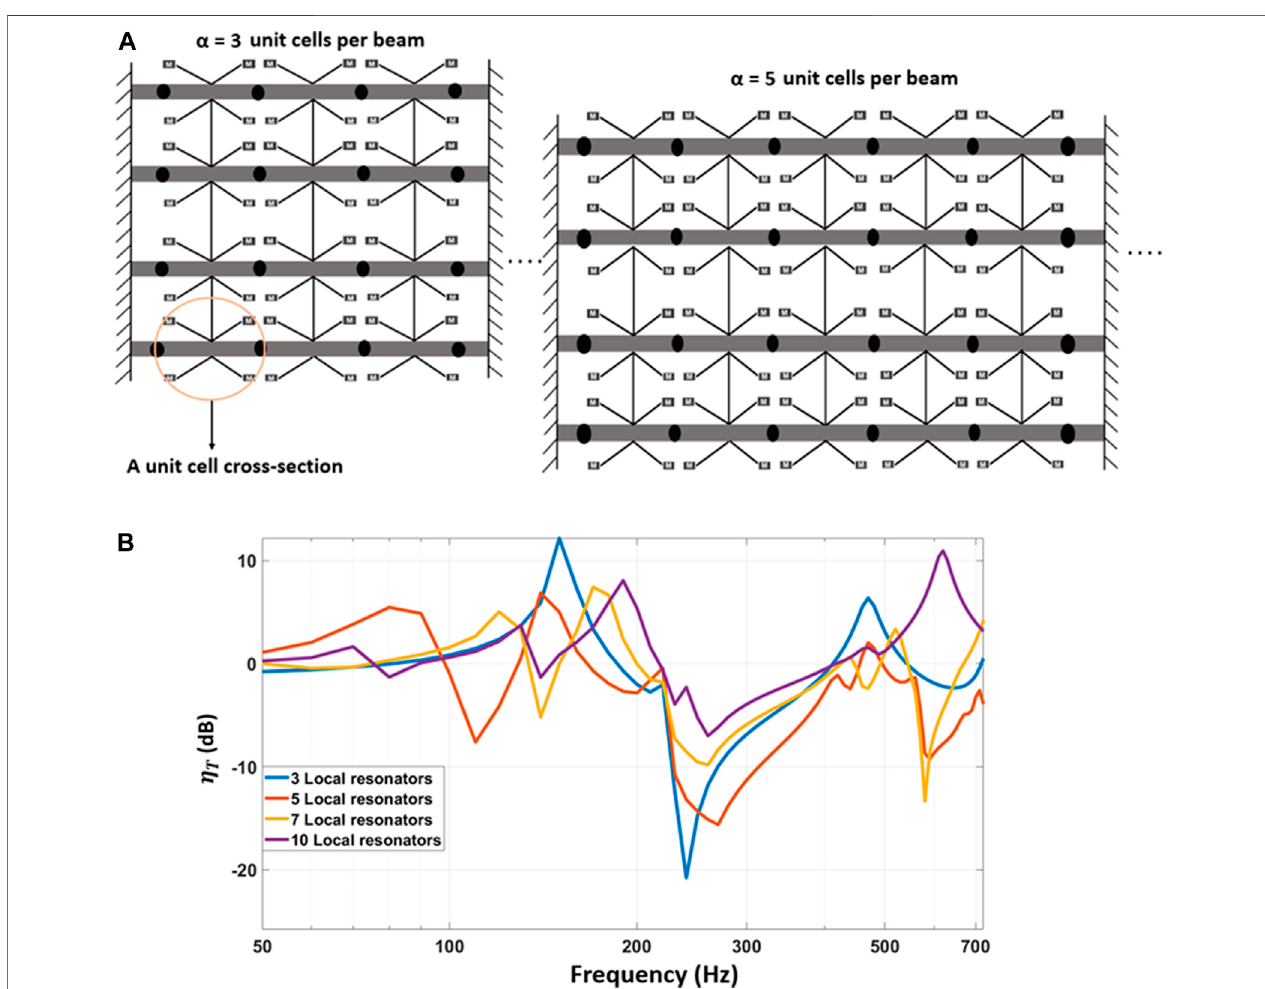
FIGURE 10 | Effect of increasing the number of local resonators (unit cells) on the transmissibility behavior of the layered metamaterial vibration attenuation structure: (A) Graphicalcartoonrepresentationofchangesinthelayeredmetamaterialstructureasthenumberofunitcells(localresonators)perbeamincreasesfrom α (cid:1) 3 to α (cid:1) 5. (B) Model simulation of transmissibility when increasing the number of local resonators.